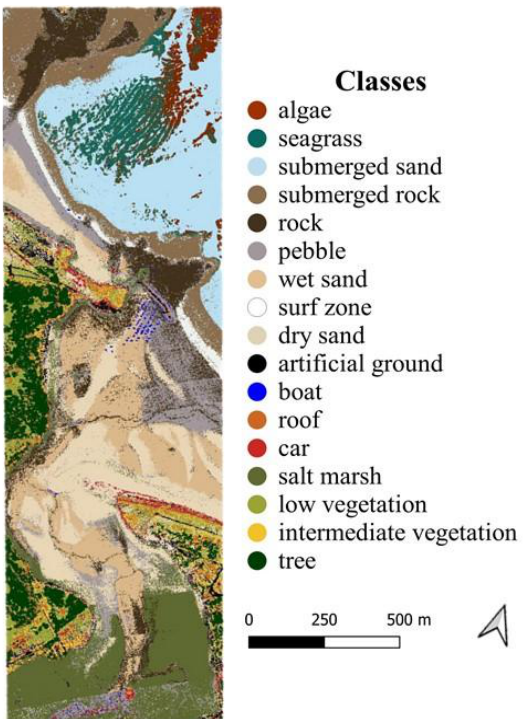
Figure 5. Coastal habitats map obtained when classifying a selected set of bispectral waveform features.